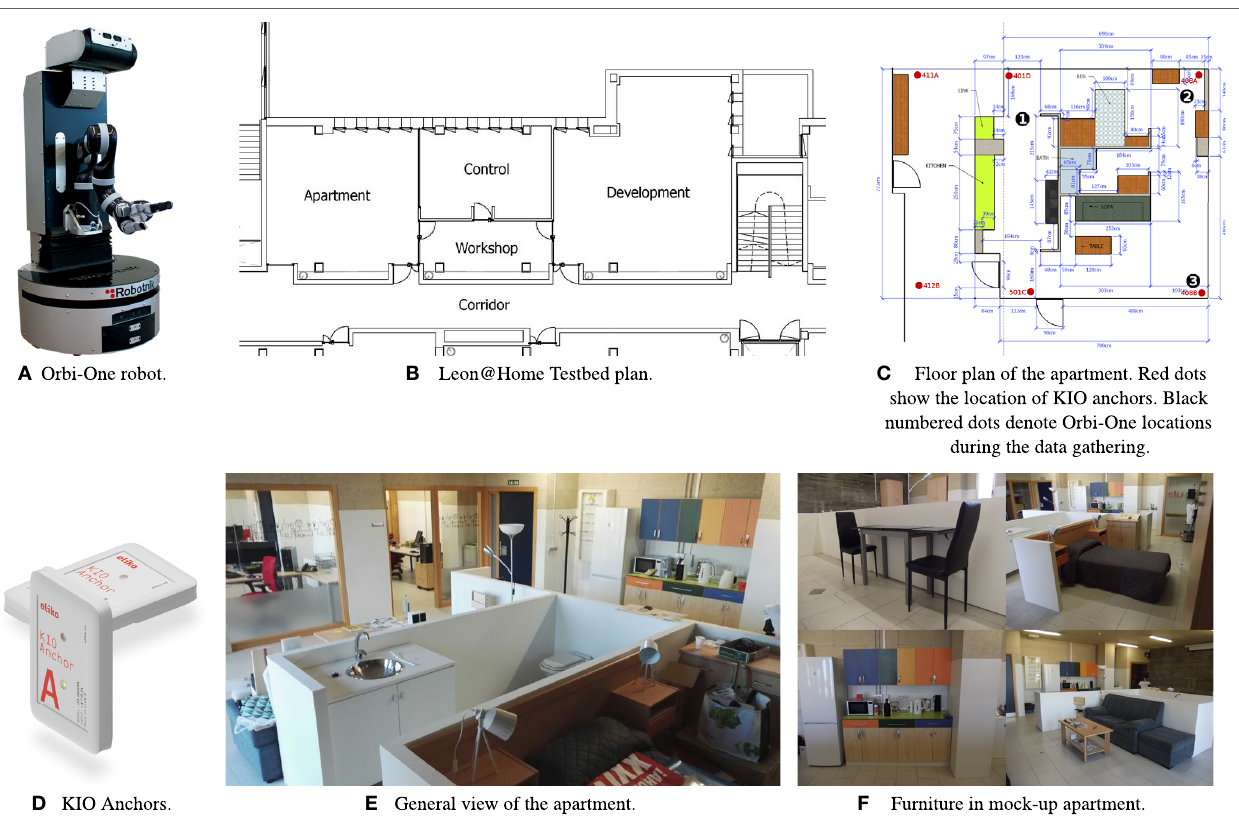
Figure 1B : a mock-up apartment, a control zone with direct vision (glass wall) into the apartment, a small workshop, and a larger development zone, where researchers